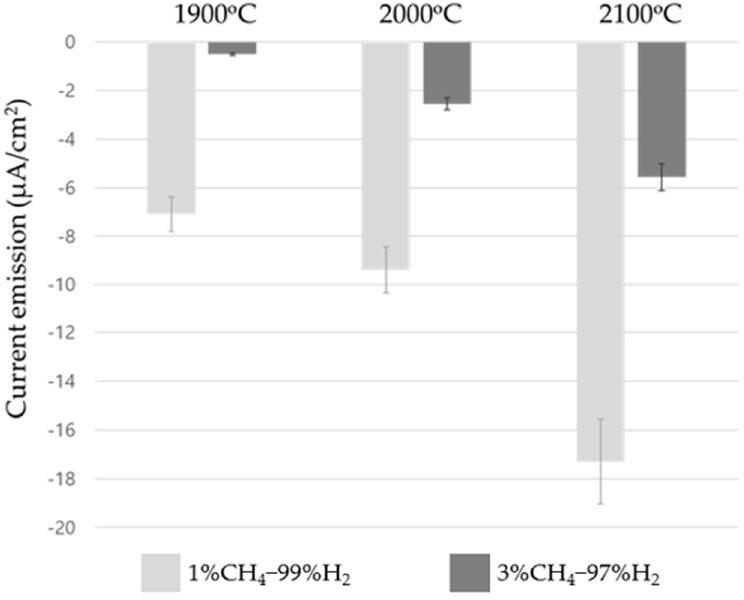
Figure 6. Current measured at filament temperatures of 1900 °C, 2000 °C, and 2100 °C at 1% CH 4 – 99% H 2 (light gray bars) and 3% CH 4 –97% H 2 (dark gray